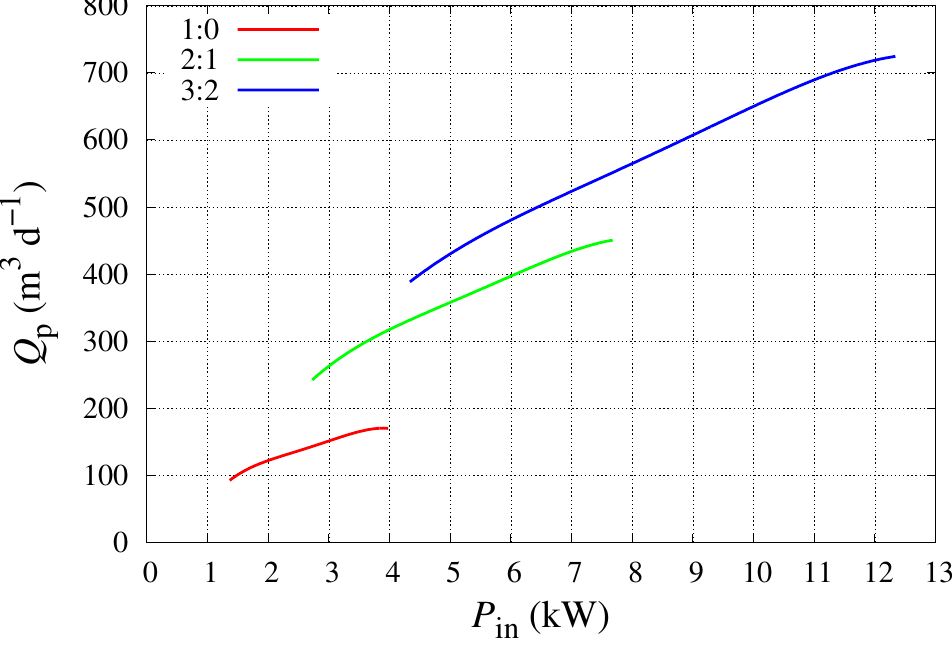
Figure 7. Curves of maximum Q p for different BWRO configurations using sample 20 (Table 1) as C f .